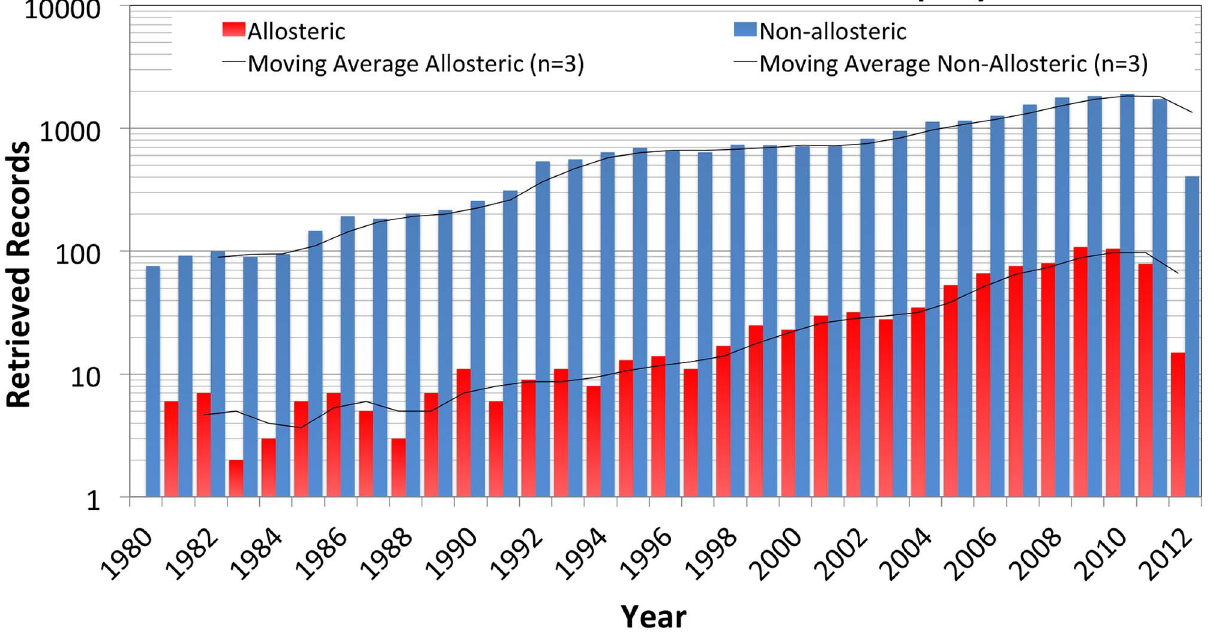
Figure 2. Distribution of retrieved allosteric and non-allosteric publications sorted per year. Overall the allosteric records made up a small fraction of the total records in ChEMBL-14. However a slight upward trend was seen. Note that the y-axis is logarithmic.